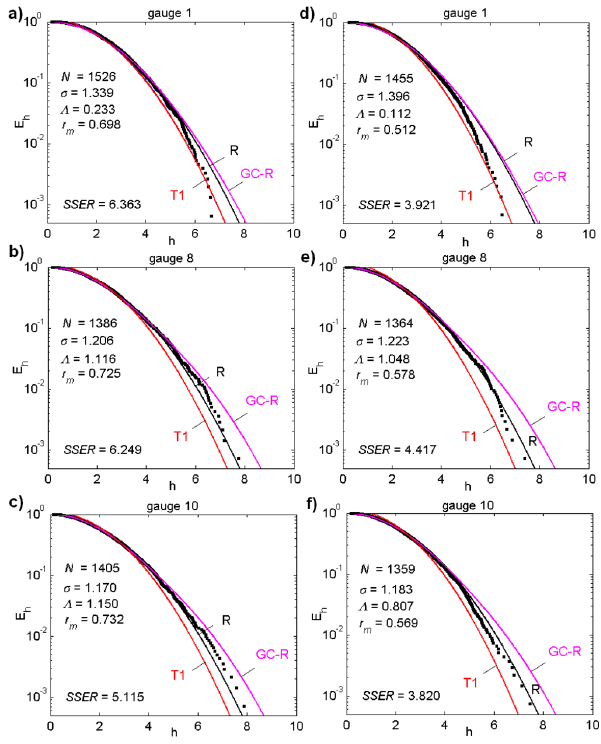
Figure 10. Exceedance distributions of wave heights along the tank for (a–c) test 8228 and (d–f) test